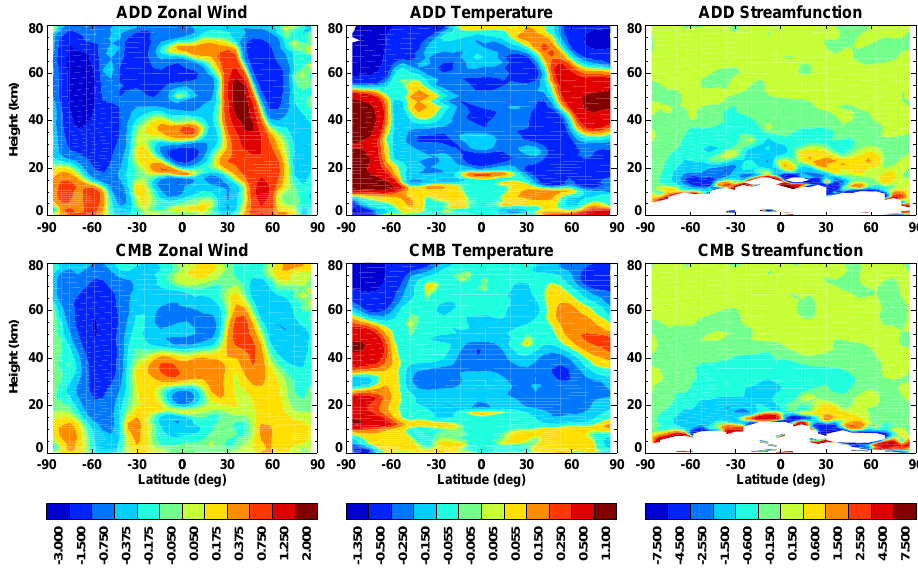
Fig. 9. Run mean, annual mean difference from the reference run for zonal wind (left, m/s), temperature (middle, K) and mass streamfunction (right, kg/m/s, values outside the (-9,9) interval not plotted). Top panels: sum for the auroral zone electrons, SPEs and GCR runs. Bottom panels: combined run.